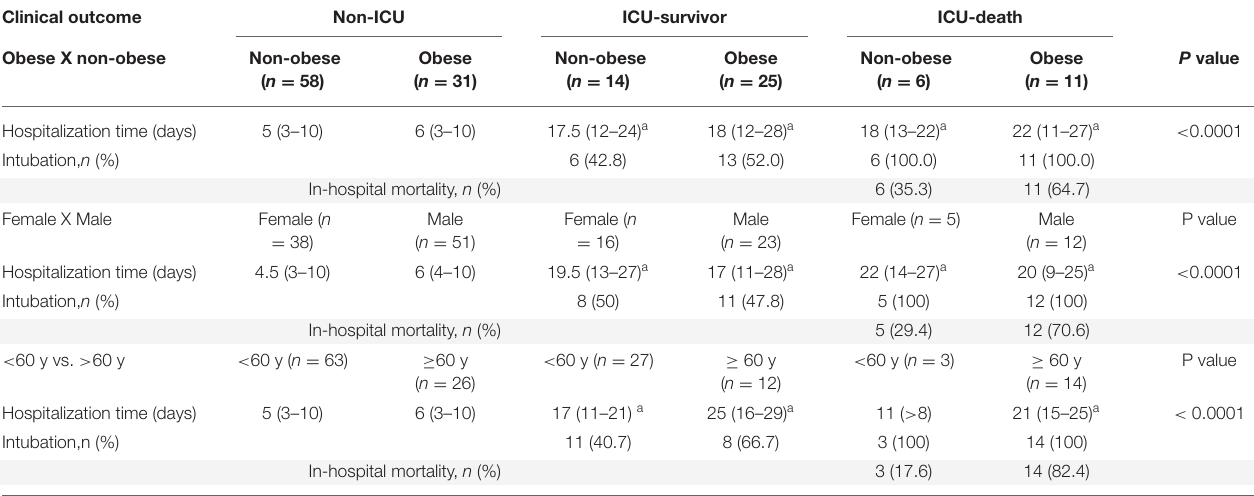
TABLE 3 | Comparison of the Clinical Outcomes of Patients between the Non-obese vs. Obese, Female vs. Male, and by age range groups. Clinical outcome Non-ICU